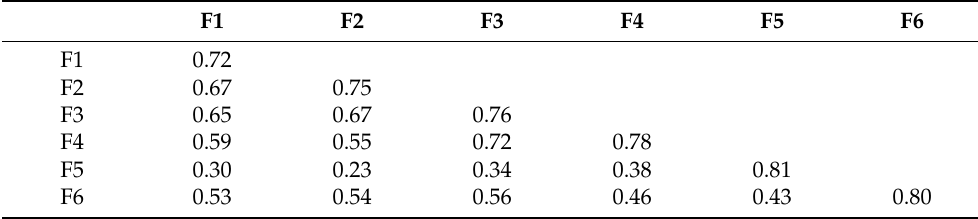
Table 2. Discriminant validity of